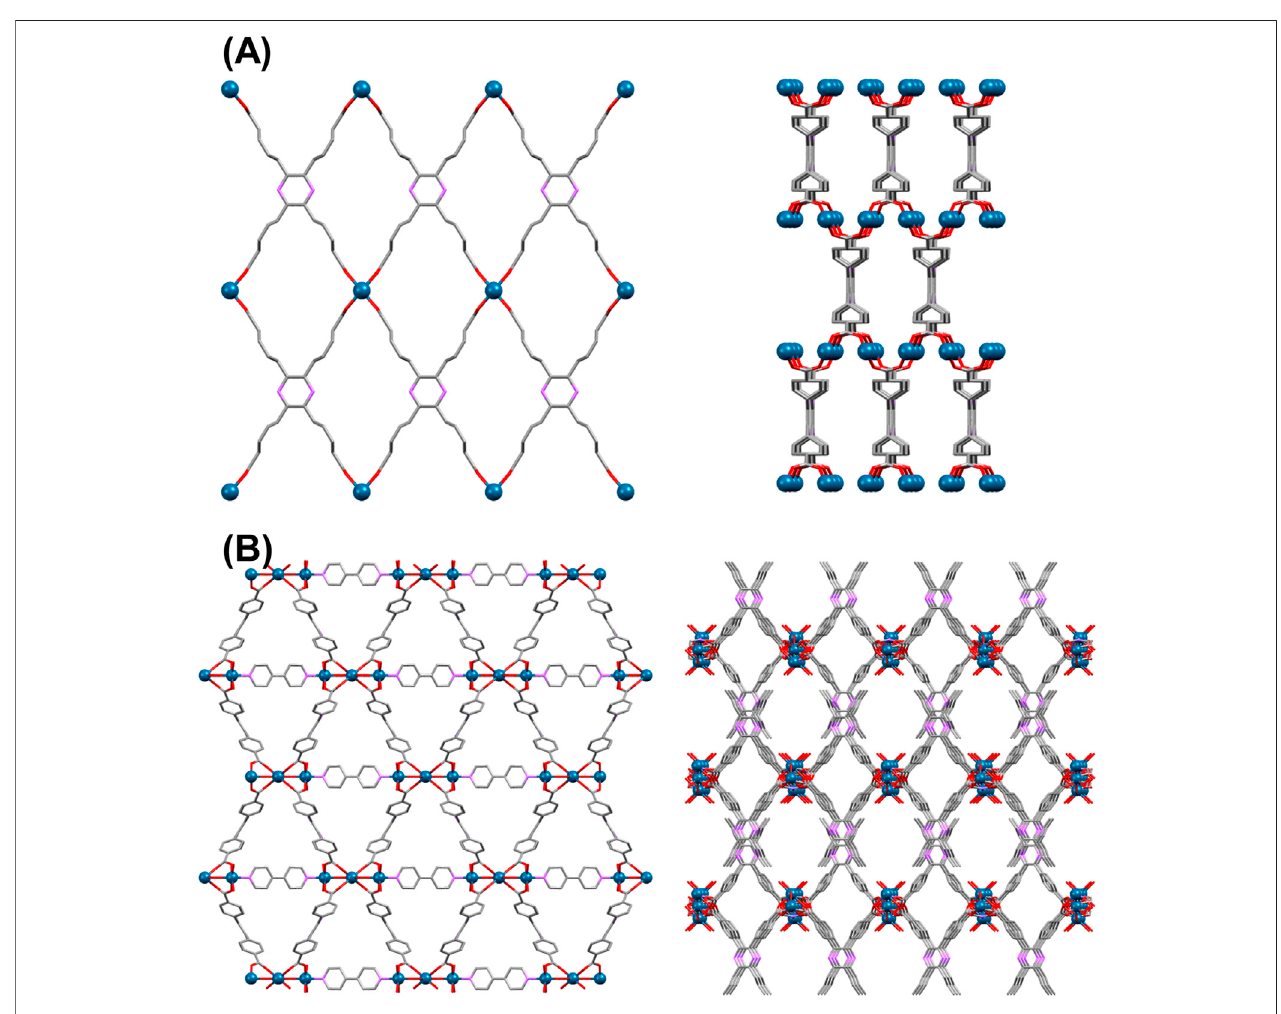
FIGURE 4 | Some representative structures of Zn-MOFs for living cell determinations. (A) by Hua Yang (Hu et al., 2020); (B) by Wei-Ping Zhang (Wu et al., 2021).